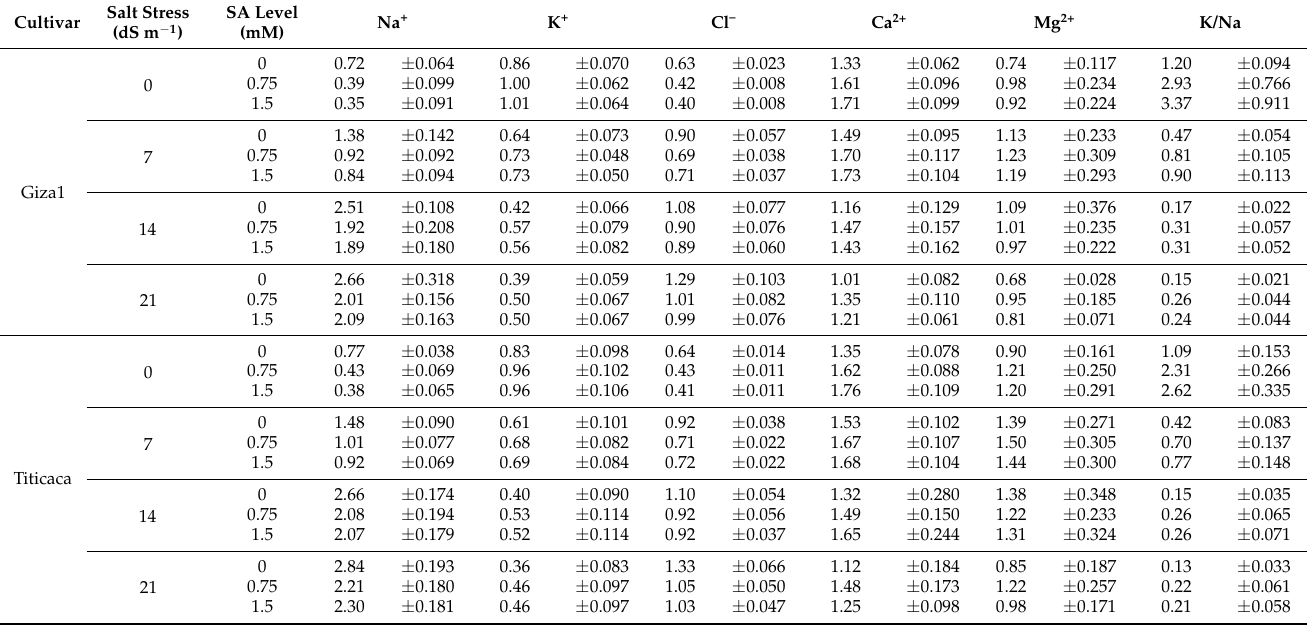
Table 1. The concentrations of ions (%) in quinoa shoots treated with varied salicylic acid (SA) concentrations grown under different salinity